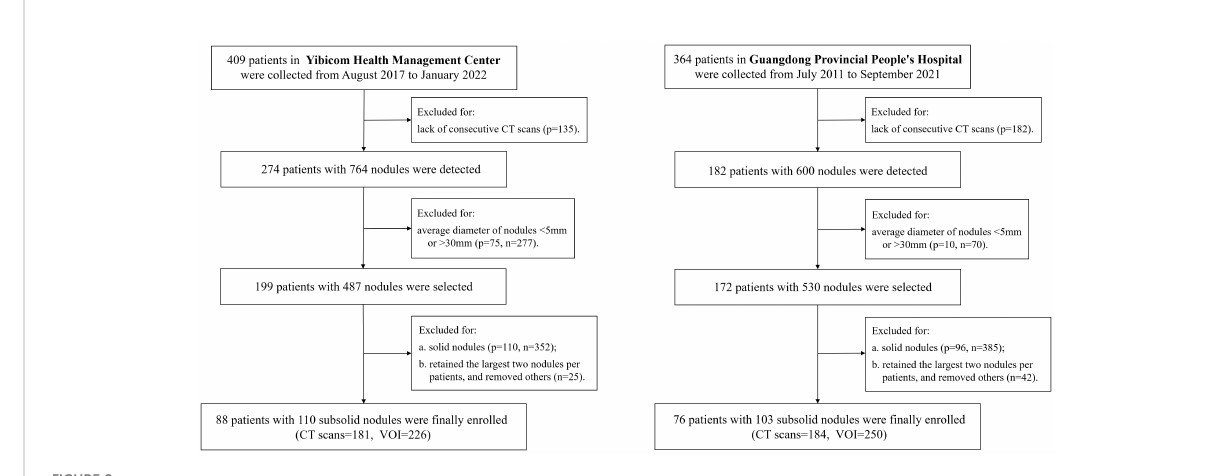
FIGURE 2 Flowchart of case selection on the external data set.